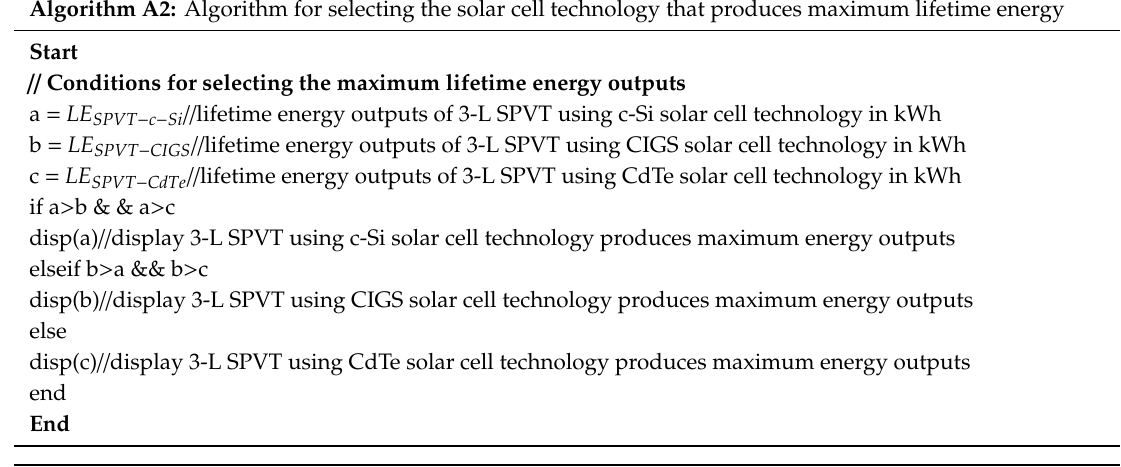
Algorithm A2: Algorithm for selecting the solar cell technology that produces maximum lifetime energy